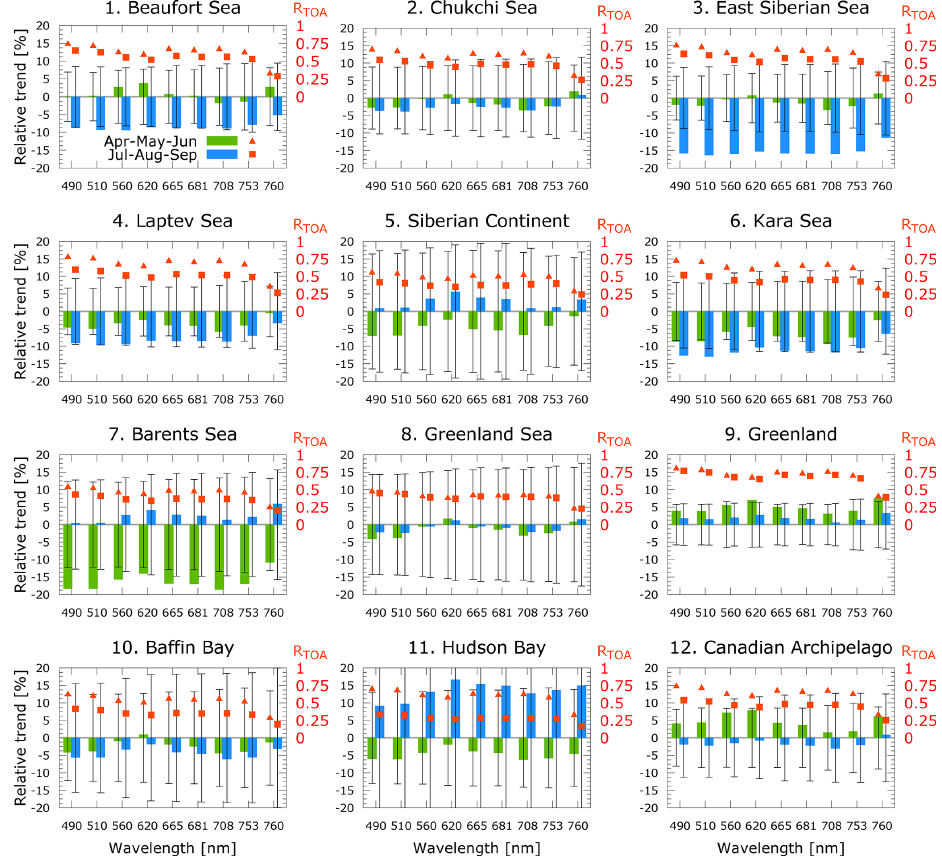
Figure 7. R TOA λ trends for the 12 regions defined in Fig. B1 for spring (AMJ, green bars) and summer (JAS, blue) months. The black bars represent the 2 σ standard deviation of the trend. The secondary y axis displays the absolute mean values of reflectance for each Arctic sector. The trend values are relative to the respective lead season and express the total change throughout the